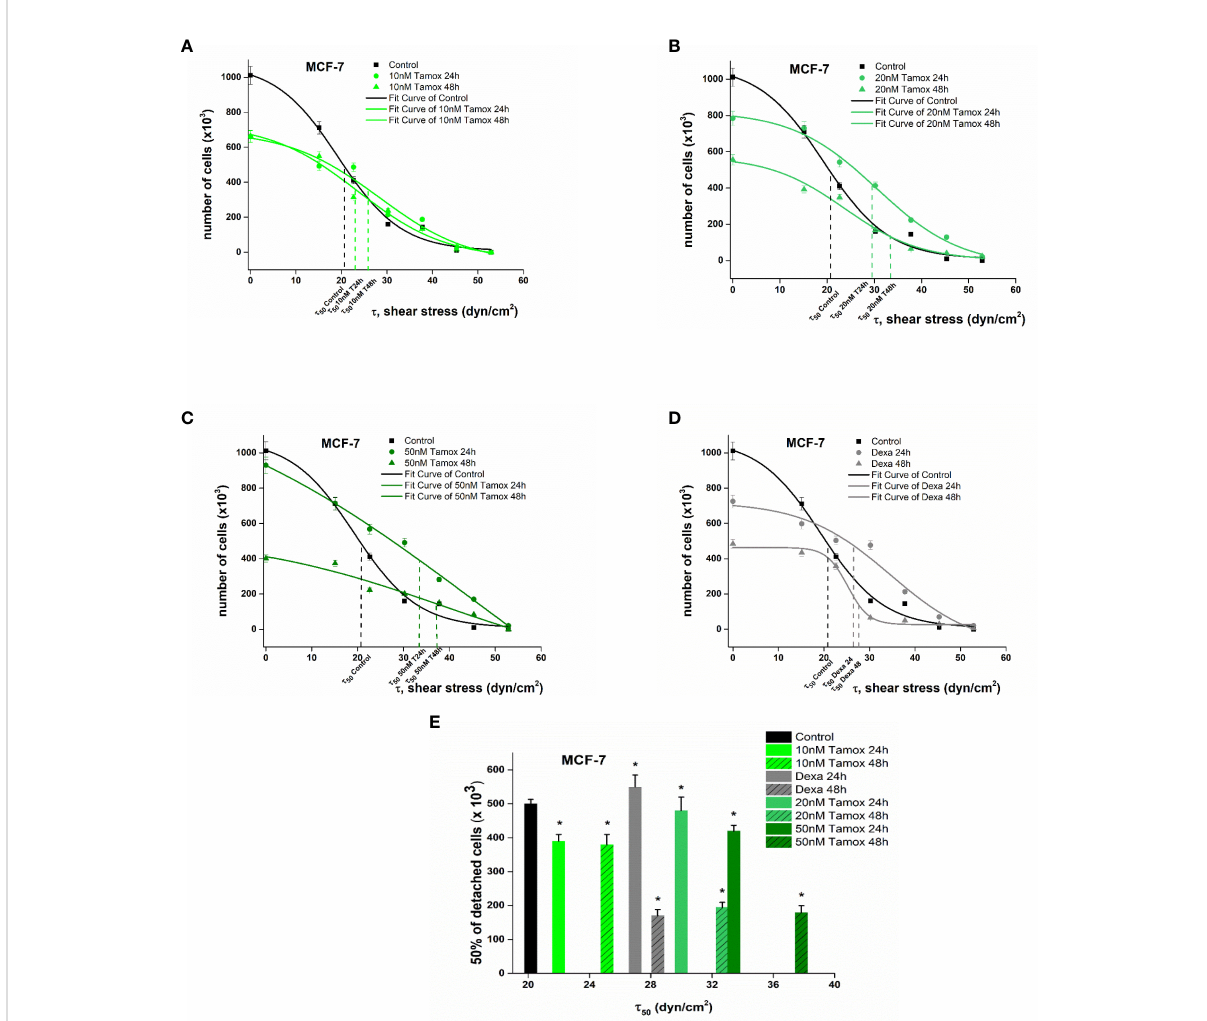
FIGURE 5 Plotted curves of the number of remaining MCF-7 cells post-detachment event vs the essential shear stress for detachment (A – D) . The applied shear stress is zero to attached cancer cell upon the center of the disc (r = 0) where the remained cells after detachment are 100%, no detachment was occurred and maximum when r = R disc = 1 cm where all cancer cells where detached. Percentage number of remaining cells of control and treated MCF-7 breast cancer cells upon the collagen coated surface after applying a range of 0 – 200 dyn/cm 2 shear stresses (E) . Data express mean values ± SD of at least three repeated experiments, *p